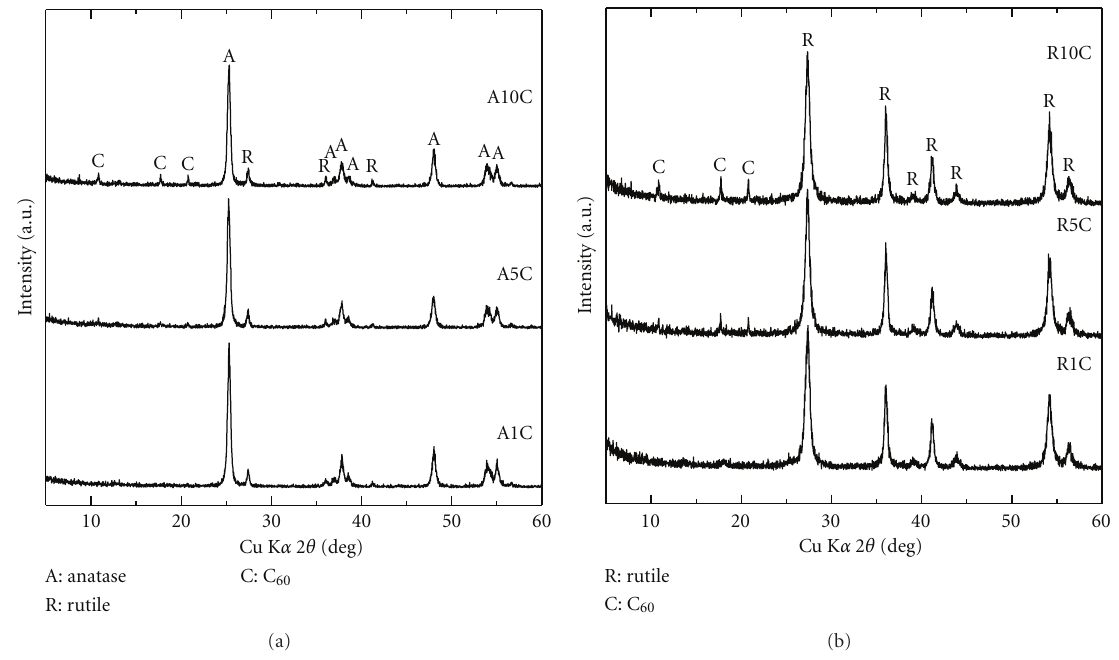
Figure 2: XRD patterns of the TiO 2 -C 60 composite samples. (a) The A1C, A5C, and A10C samples, (b) the R1C, R5C, and R10C samples.